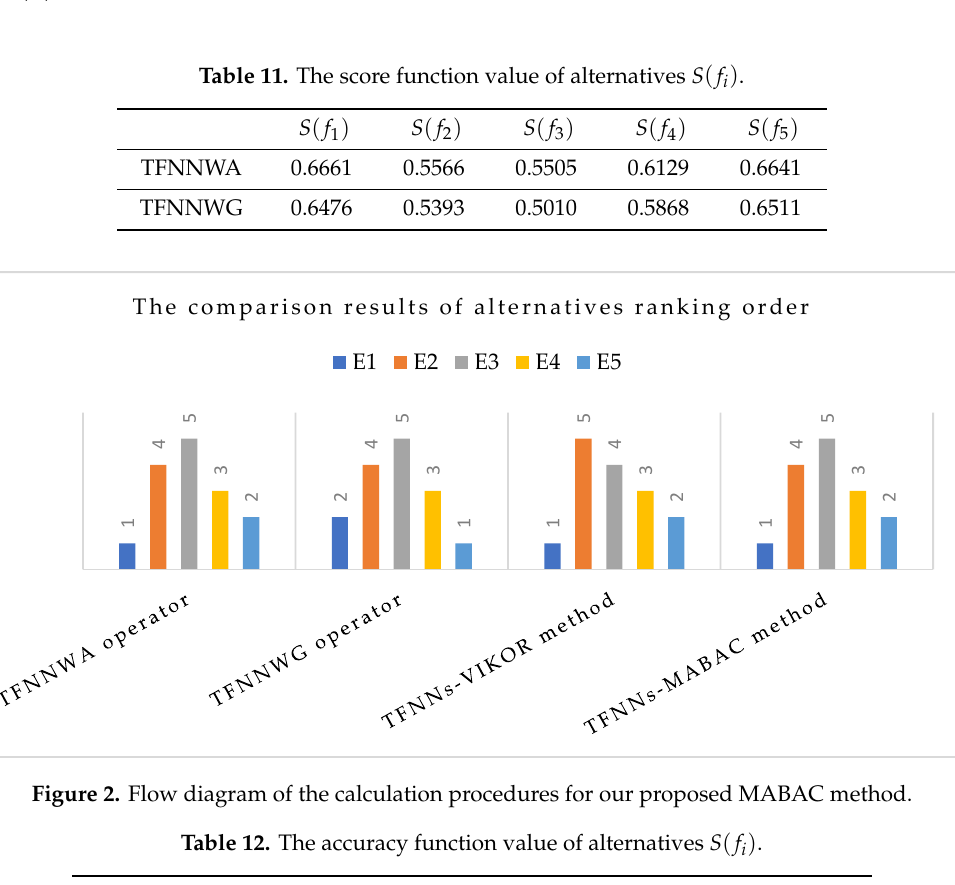
Table 12. The accuracy function value of alternatives (cid:1845)((cid:1858) (cid:3036) ) .